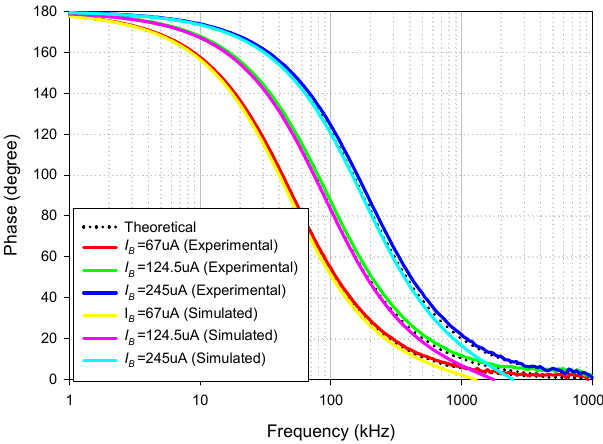
Figure 16. Frequency gain response of AP+ with different I B values.